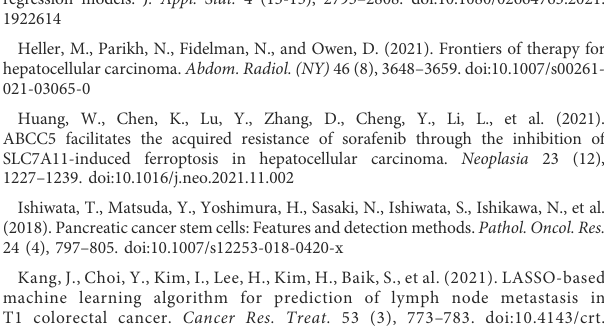
Predict candidate small molecules of